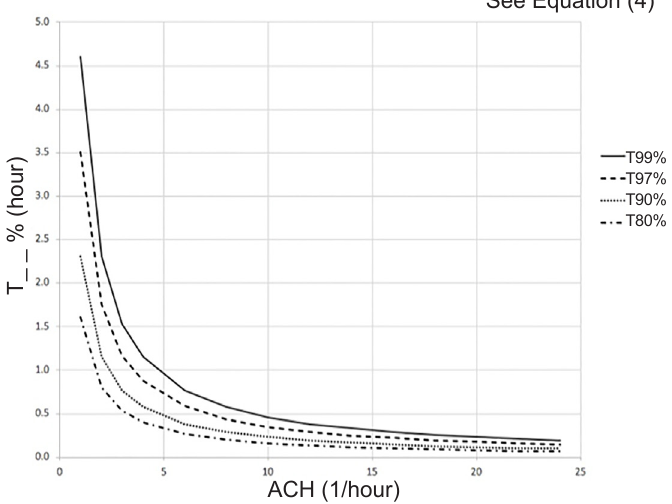
Figure 2. Time to reach T_ _ % of the steady state contamination concentration ratio for any reference volume. ACH , air change per hour.